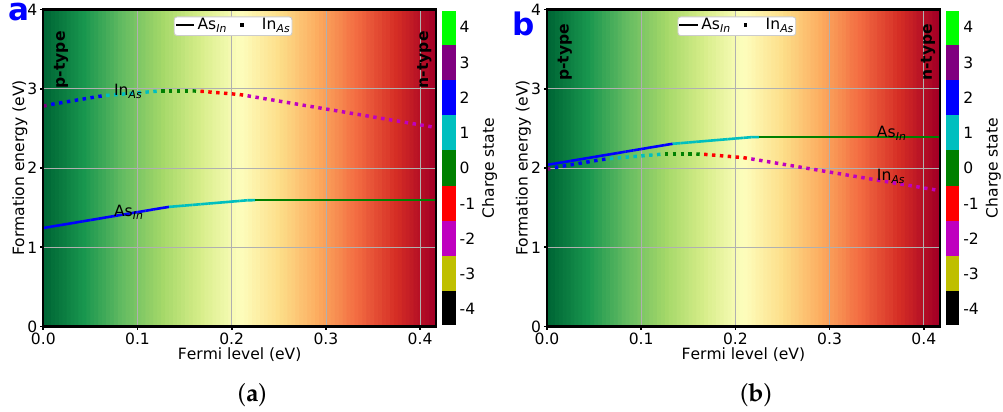
Figure 6. Formation energies as functions of E F in the ( a ) As-rich and ( b ) In-rich environment for two substitutional type point defects in zb -InAs with all possible charge states from − 4 to + 4 marked with different